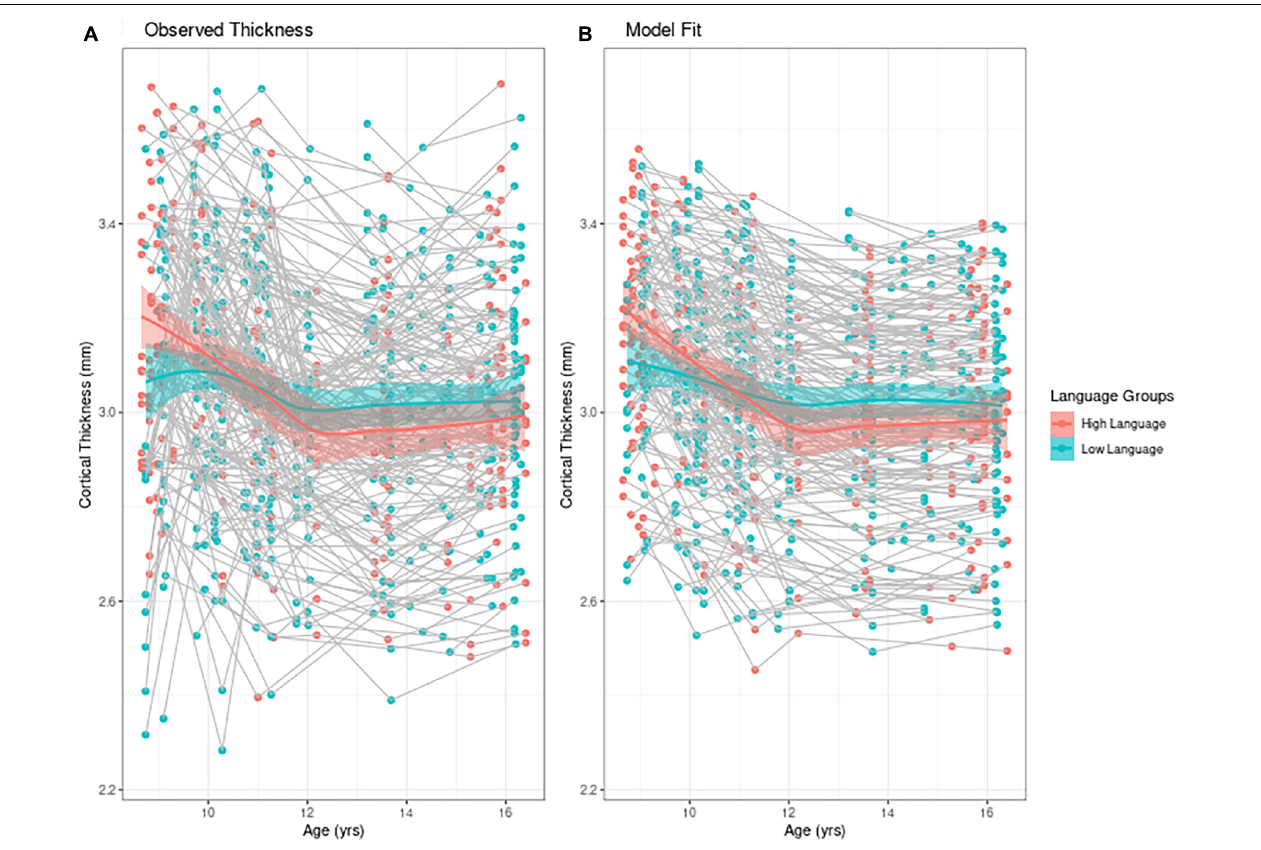
FIGURE 1 | Individual trajectories of cortical thickness (A) mean observed cortical thickness by group and (B) model fit by group. For visualization purposes only, high and low language groups are separated by median language input PCA value. In both figures the solid line represents the Loess curve fit on the observation. The six children who participated in only one MRI session are represented with a single point in the